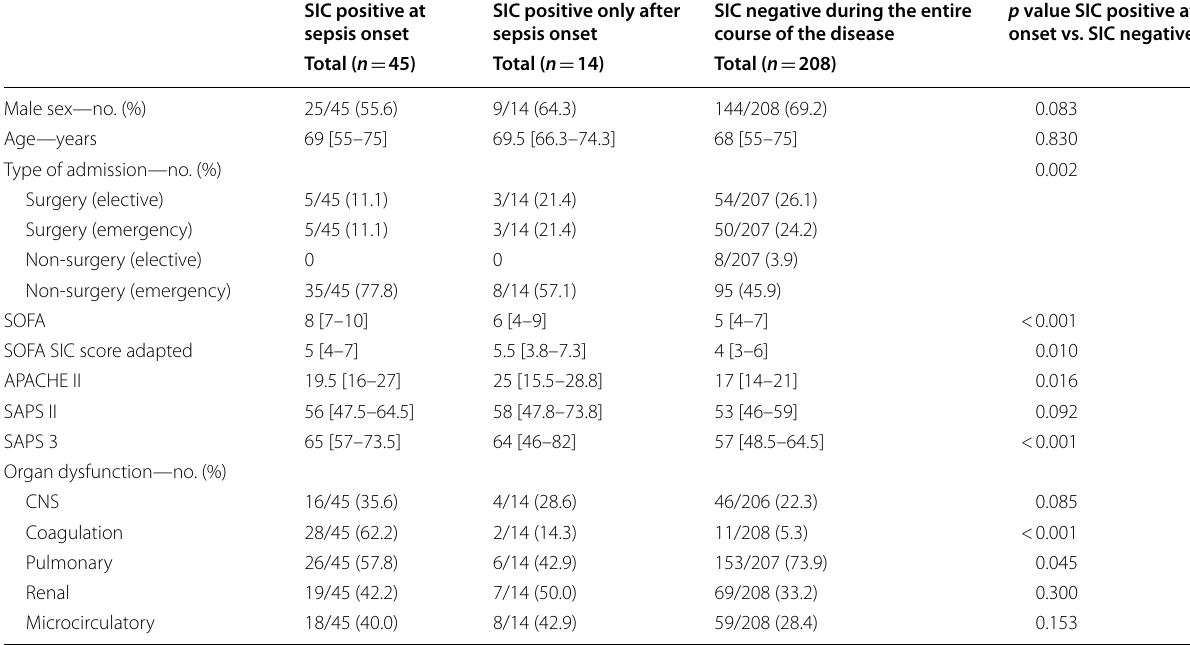
If not otherwise indicated, the data are presented as absolute frequencies and percentages in round brackets, or median and interquartile range [IQR]. Microcirculatory organ dysfunction defined in HYPRESS as: “Lactate > 1.5 above the normal upper range and/or base deficit 5 mmol/l and/or metabolic acidosis × ≥ with pH < 7.3 and/or depressed capillary refill/mottling and/or significant body edema (capillary leakage syndrome)” [14] APACHE Acute Physiology and Chronic Health Evaluation, CNS central nervous system, MV minute ventilation, SAPS Simplified Acute Physiology Score, SIC sepsis- induced coagulopathy, SIRS systemic inflammatory response syndrome, SOFA Sequential (sepsis-related) Organ Failure Assessment For a list of concomitant diseases, please see the Supplementary Appendix of the HYPRESS trial [14]